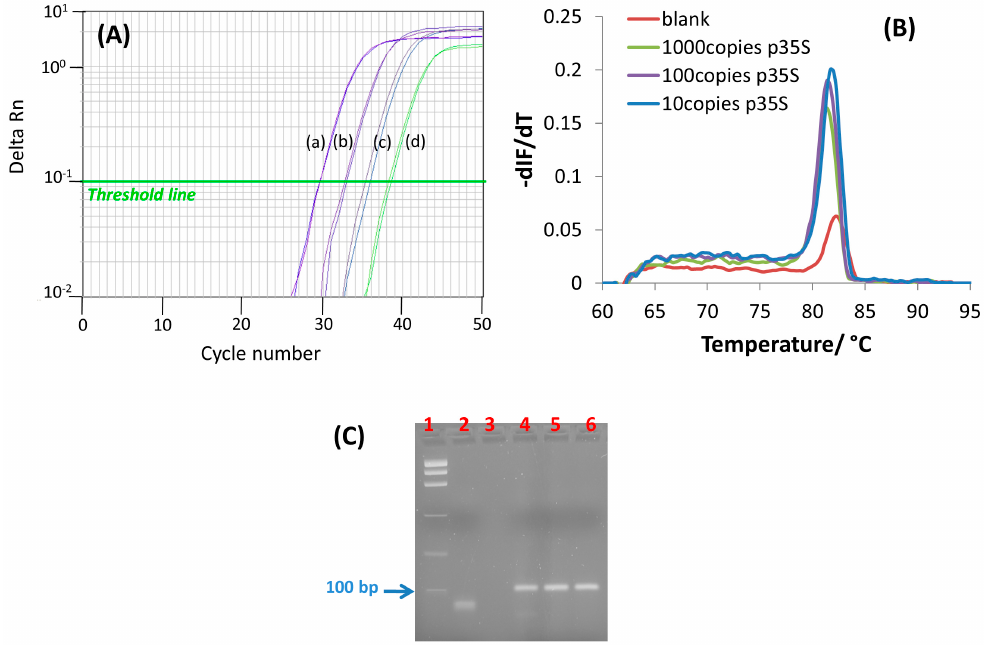
Figure 2. ( A ) Amplification curves obtained for real-time fluorescence-based PCR of genomic DNA extracted from MON810 maize flour. The initial number of P35S copies per assay was ( a ) 10 3 , ( b ) 10 2 , ( c ) 10, ( d ) non-template control. The horizontal green line indicates the threshold level used to establish the calibration curve; ( B ) Fluorescence-based melt curves recorded after the real-time PCR amplification experiments presented in ( A ); ( C ) 3% Agarose gel electrophoresis (in 1× TBE buffer) of PCR products from different initial number of P35S copies per assay (lane 1, ladder; lane 2, non-template control, lane 4, 10 copies, lane 5, 10 2 copies; lane 6, 10 3 copies).